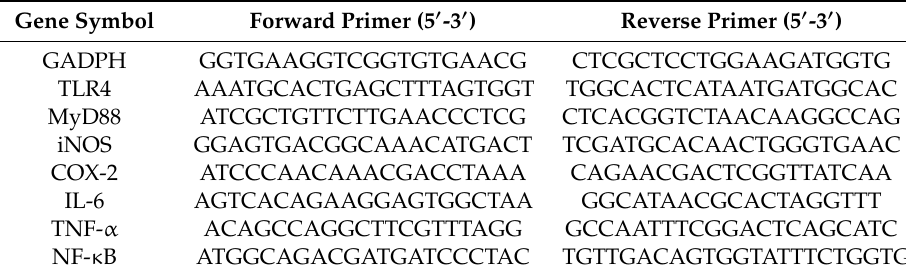
Table 2. Primer sequences of di ff erent inflammatory